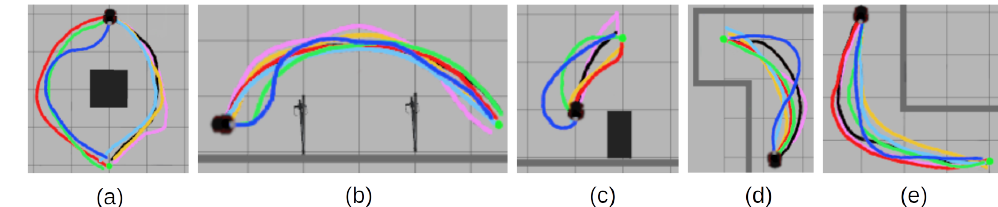
Figure 5. Examples of experimental results in a simulated environment with policy trajectory comparison to the recorded ground truth. The ground truth trajectories were not used as samples in the proposed neural network training. The handcrafted scenarios show the similarity to expert motion even in previously unseen scenarios. ( a , b ) Examples with obstacles between the robot and the goal. ( c ) An example with a compromised start location. ( d , e ) Examples of navigating around corners.